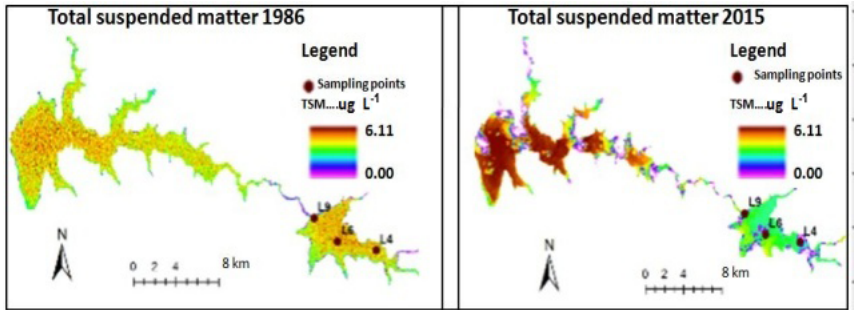
Figure 5. Spatial variations of Total Suspended Matter 1986 and 2015.